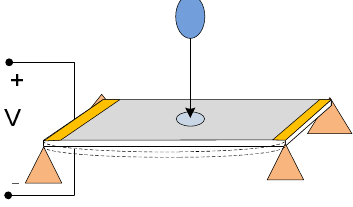
Figure 2. Piezoelectric bridge cantilevers: two edges are bound.